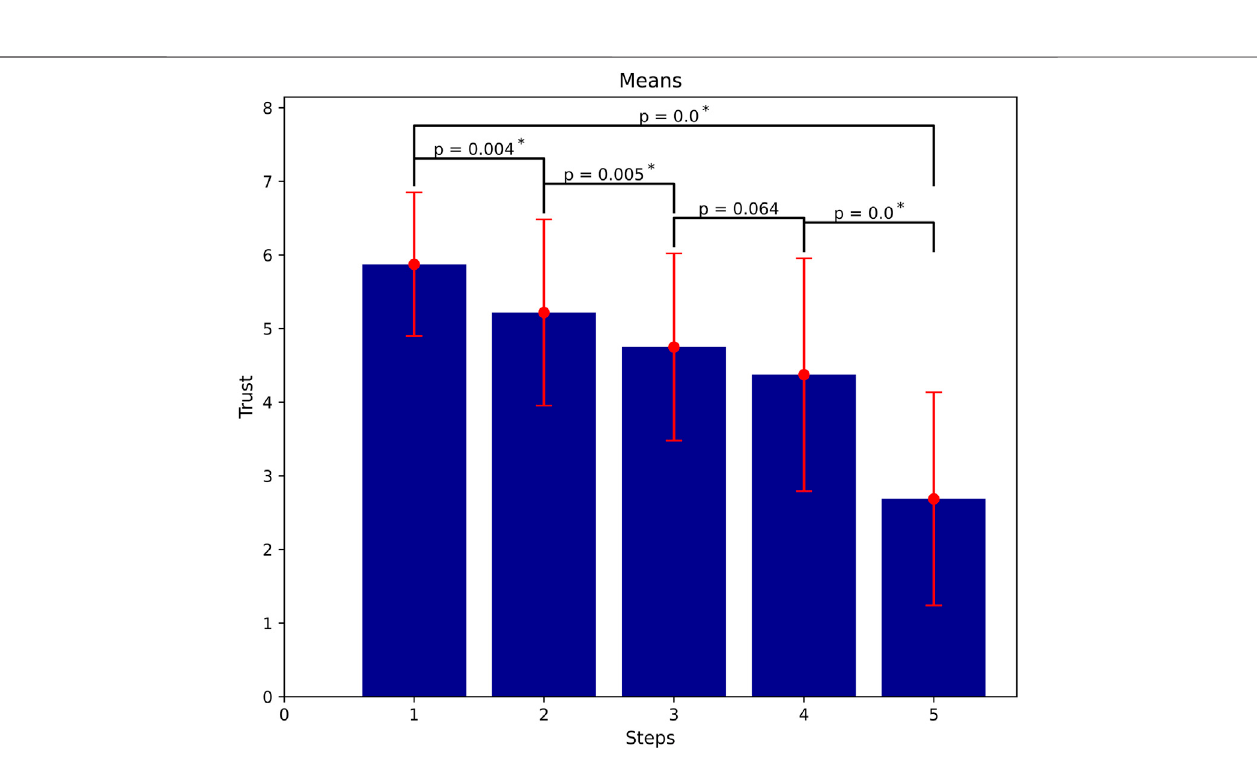
Frontiers in Arti fi cial Intelligence |